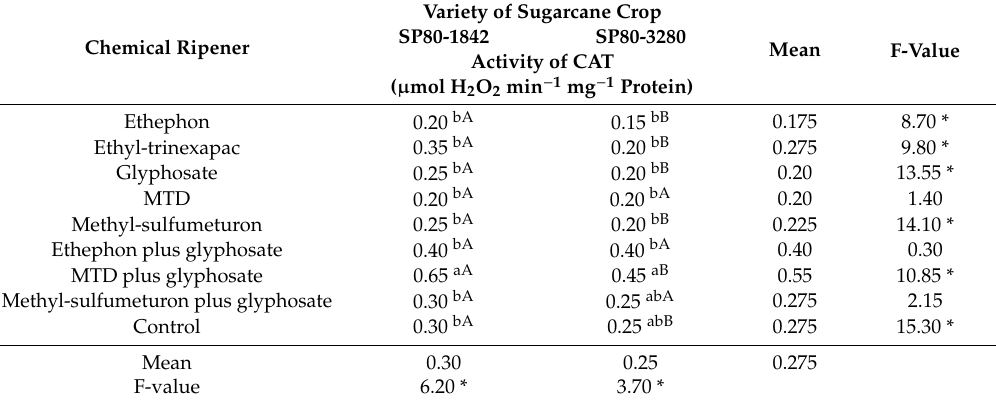
Table 5. Interaction e ff ect of chemical ripening agents and varieties of sugarcane on the activity of catalase.